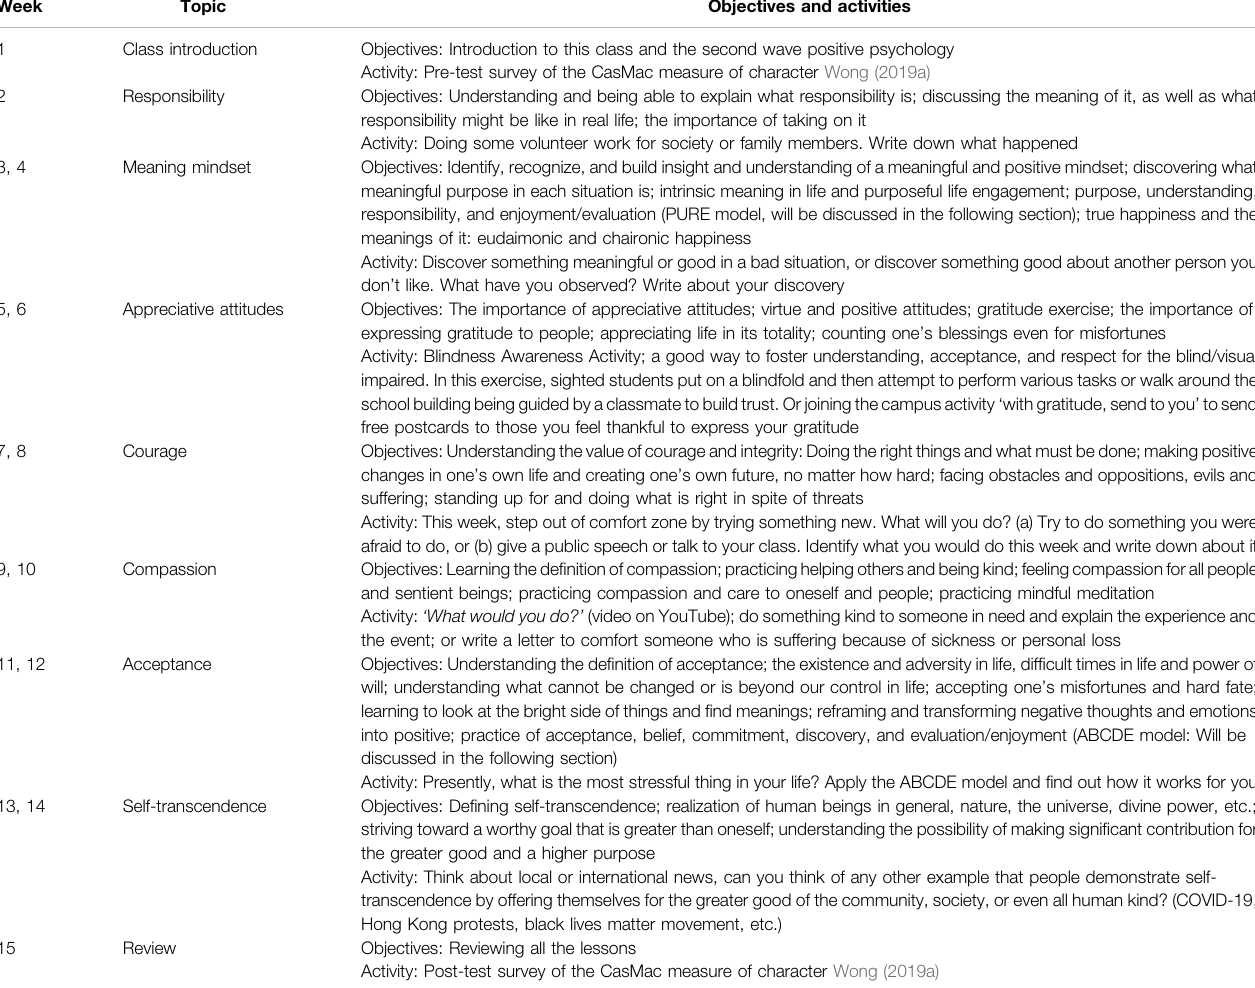
TABLE 1 | Syllabus of the meaning-centered positive education. Week